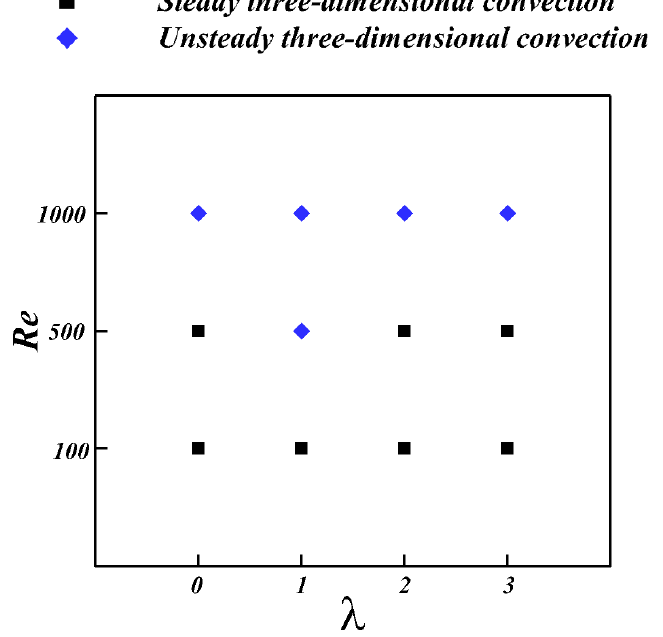
Figure 3. Bifurcation map as a function of λ and Re .